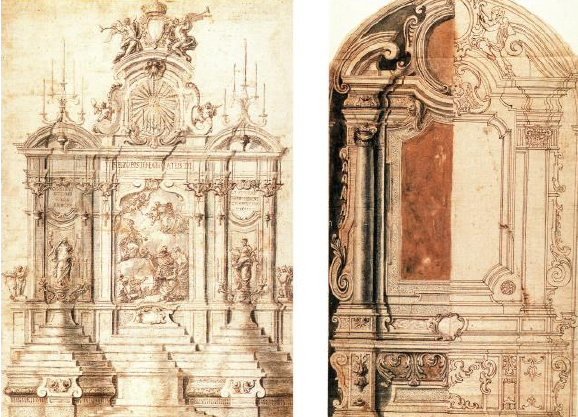
Figure 14 - Ferdinando Sanfelice, from left, Drawing of the